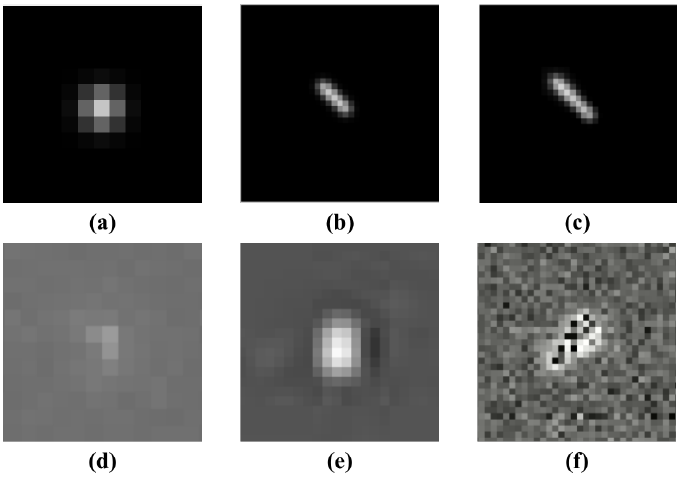
Figure 1. Schematic diagram of star spot energy distribution: ( a ) typical energy distribution of a star spot; ( b ) simulation of star spot under the condition of uniform motion; ( c ) under the condition of variable motion; ( d – f ) are the real energy distributions of the star spot in the real star images on orbit. There is a smearing phenomenon in ( f